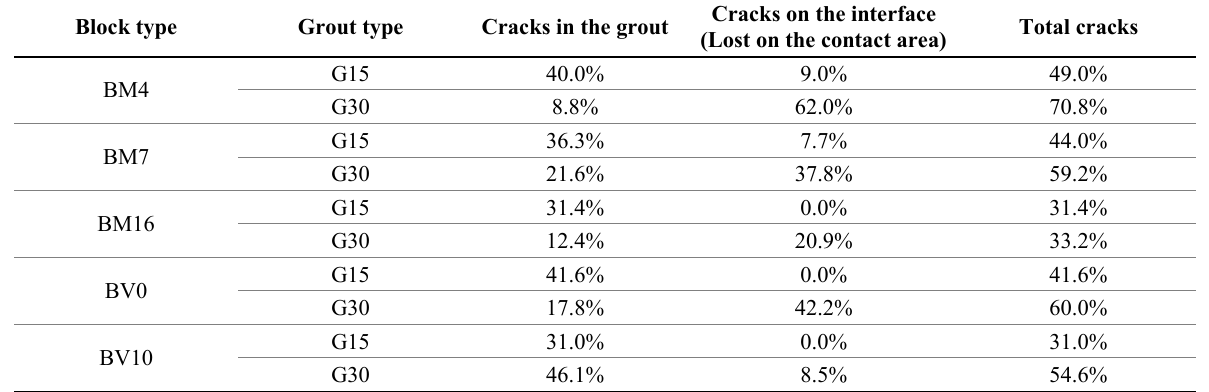
Table 6. Percentual of cracks